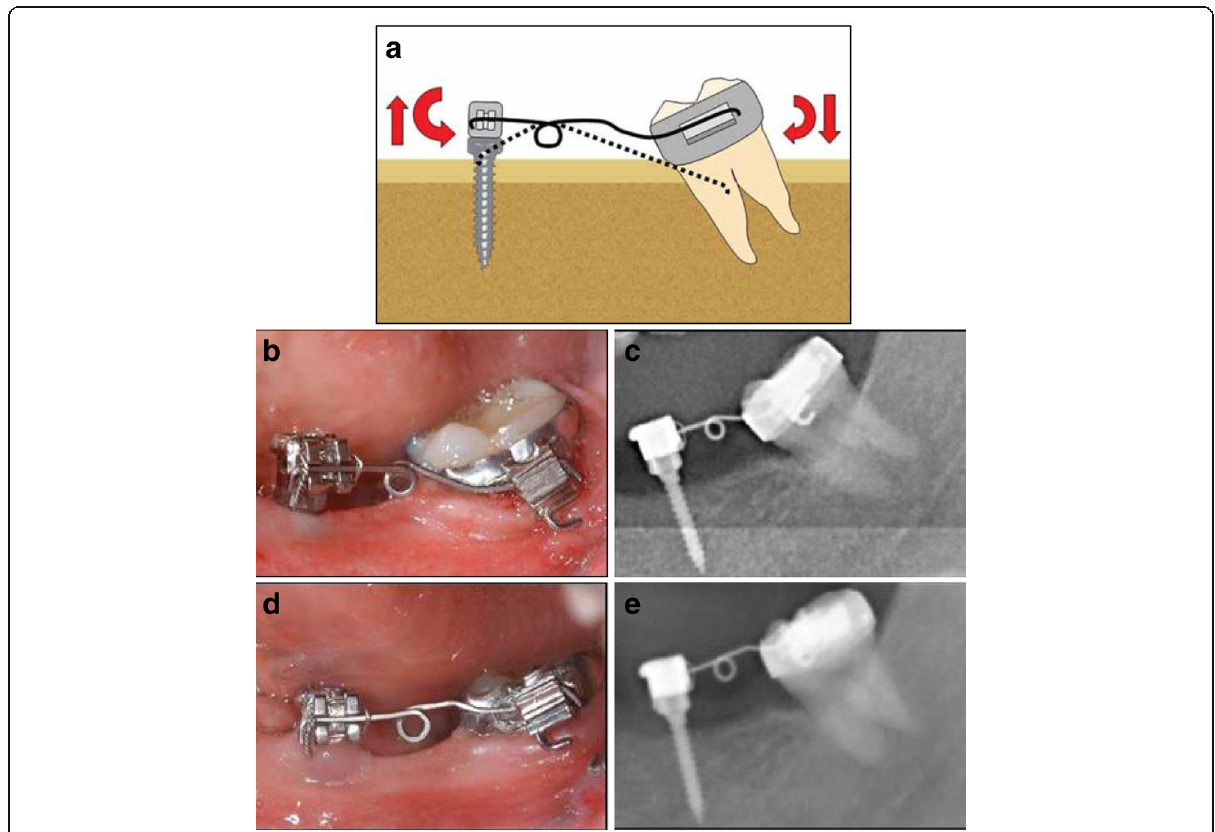
Fig. 4 Preprosthetic uprighting of #37 with a miniscrew implant and an uprighting spring. a Activation of the uprighting spring with a mesial eccentric V-bend. b , c A mini-implant with an incorporated bracket abutment placed in the alveolar ridge as an attachment of the uprighting spring. d , e After 5 months of molar-uprighting treatment, no extrusion has taken place. (From Nienkemper et al. [26], with kind permission of Journal of Clinical Orthodontics)